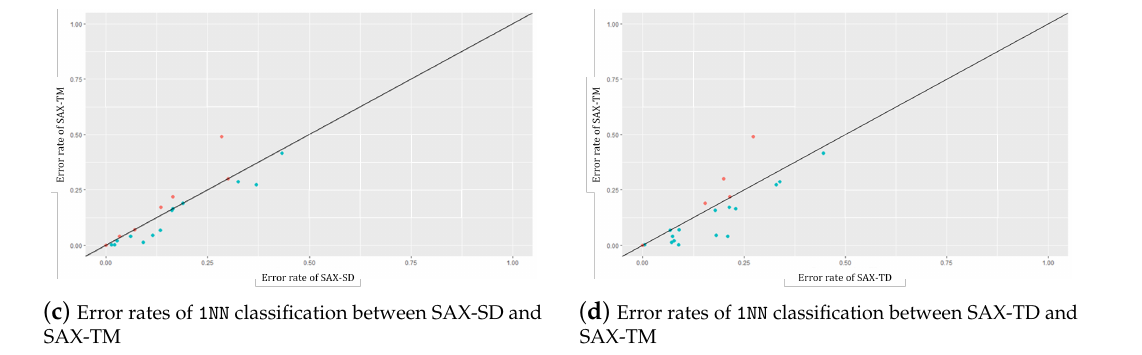
Figure 2. Comparison of error rates in 1NN classification between the existing methods and the proposed